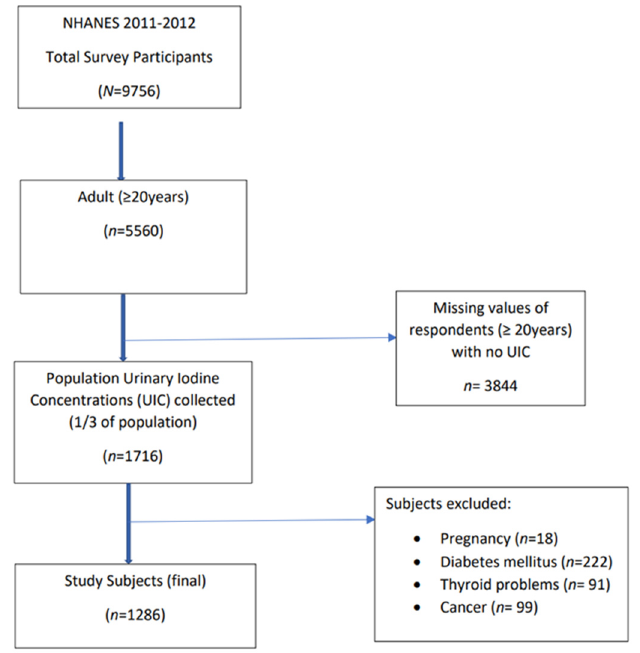
Figure 1. Flow diagram of subject inclusion. Data from the NHANES 2011–2012 cycle was used [25]. Analysis was restricted to adults >20 years of age with urinary iodine concentration (UIC) assessments. Exclusion criteria included thyroid disorders, cancer, diabetes, and pregnancy. The final sample size included 1286 participants.